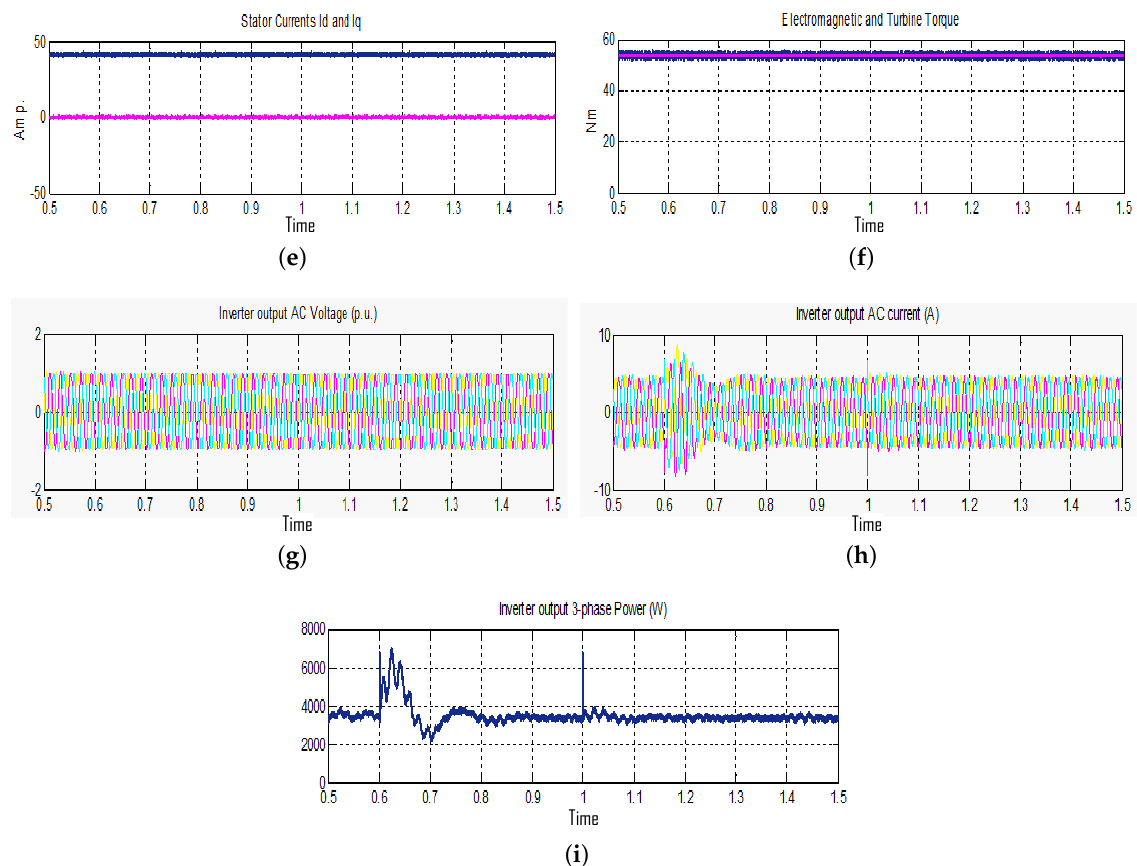
Figure 8. Results for variable load. ( a ) Wind speed. ( b ) Power coefficient. ( c ) Rotor speed. ( d ) Torques. ( e ) Turbine power. ( f ) Stator currents. ( g ) Inverter AC voltage. ( h ) Inverter AC current. ( i ) Inverter